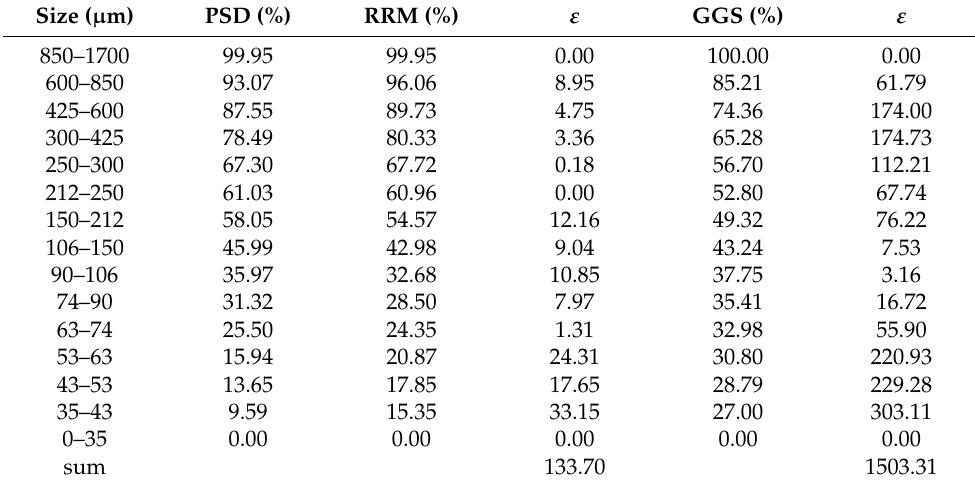
Table A3. Adjustment results of the PSD and PSDM with least squares, for 8 min.